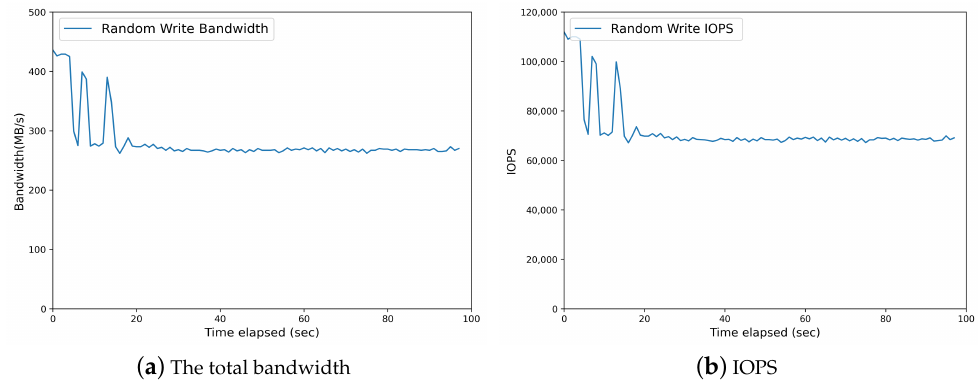
Figure 3. The total bandwidth and IOPS for random write operations on a partially occupied